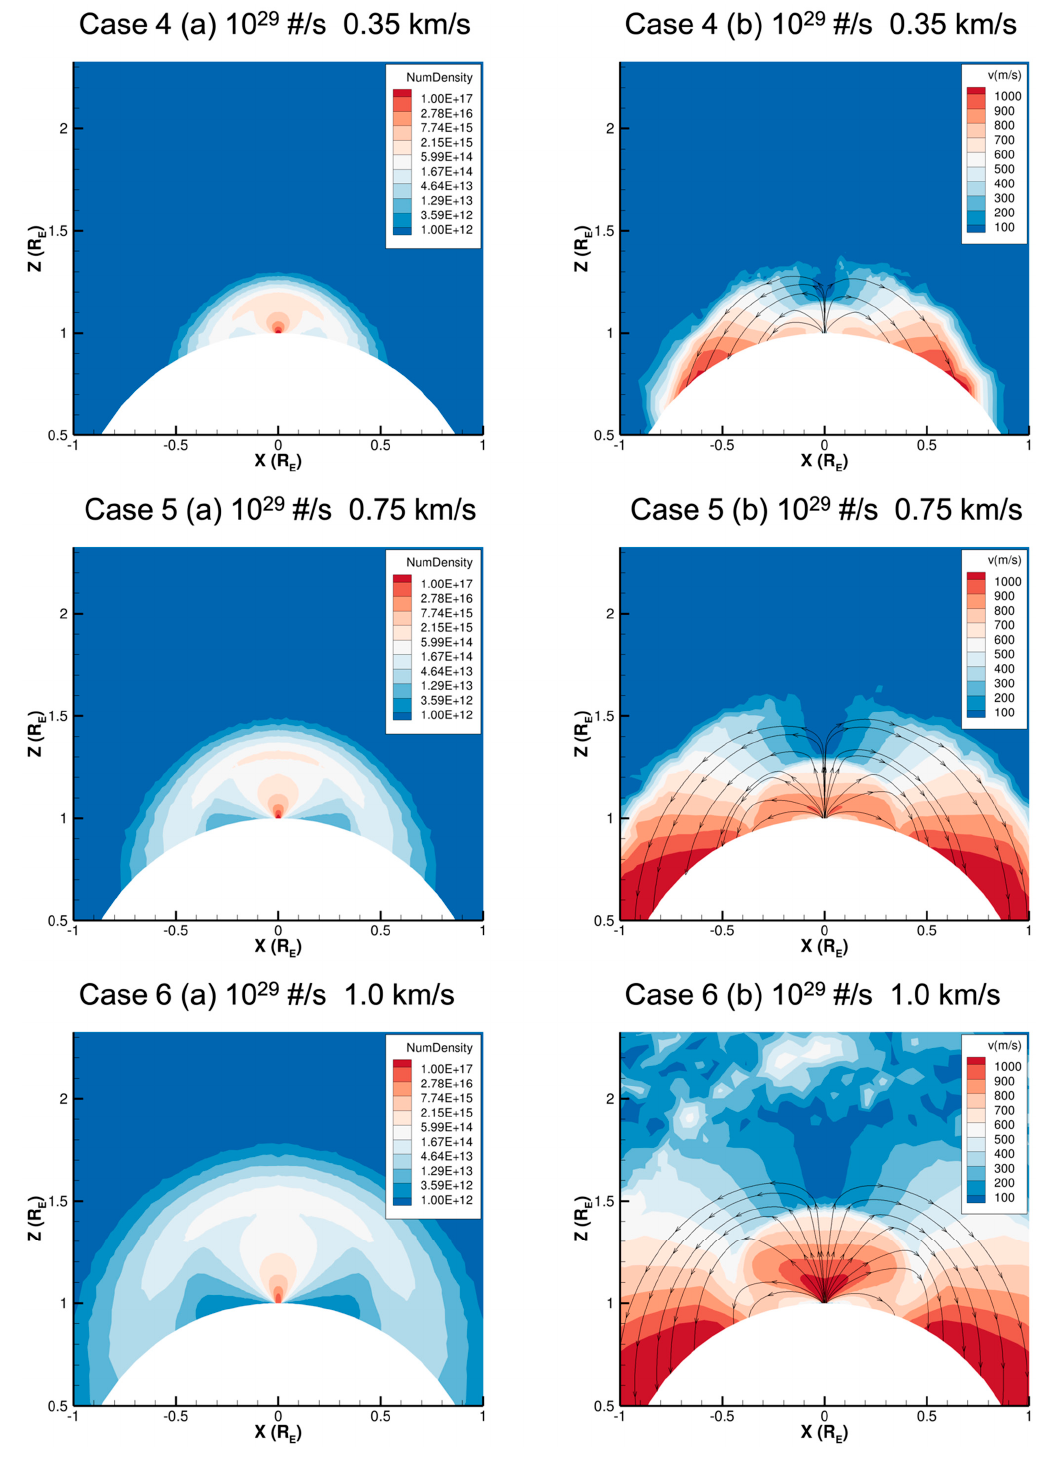
Figure 2. Column a ( Left ): Number density distribution (shown in contours with a color scale in units of # m − 3 ). The dashed, horizontal lines in case 1 represent four heights above the surface at 50, 100, 200 and 400 km. Column b ( Right ): Gas velocity distribution (shown in contour with a color scale in units of m s − 1 ). Gas flow streamlines are presented